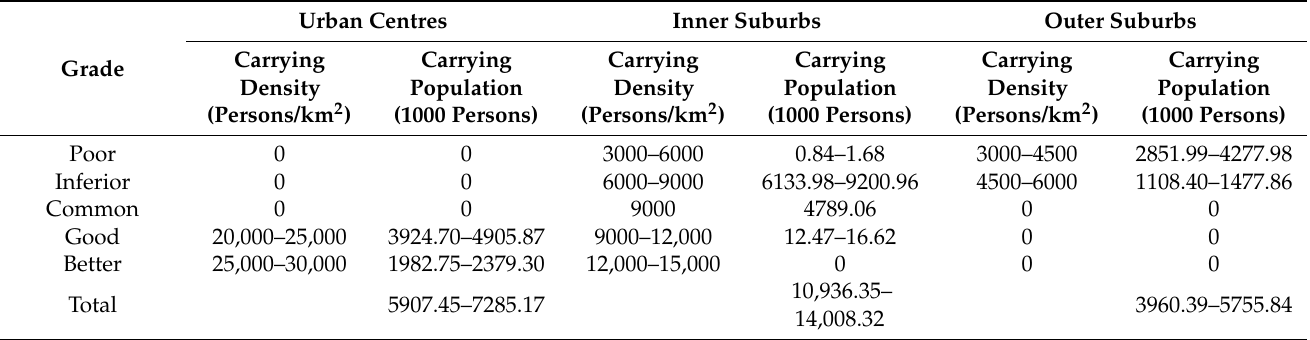
Table 7. Estimation standards per unit area and population carrying capacity in urban land